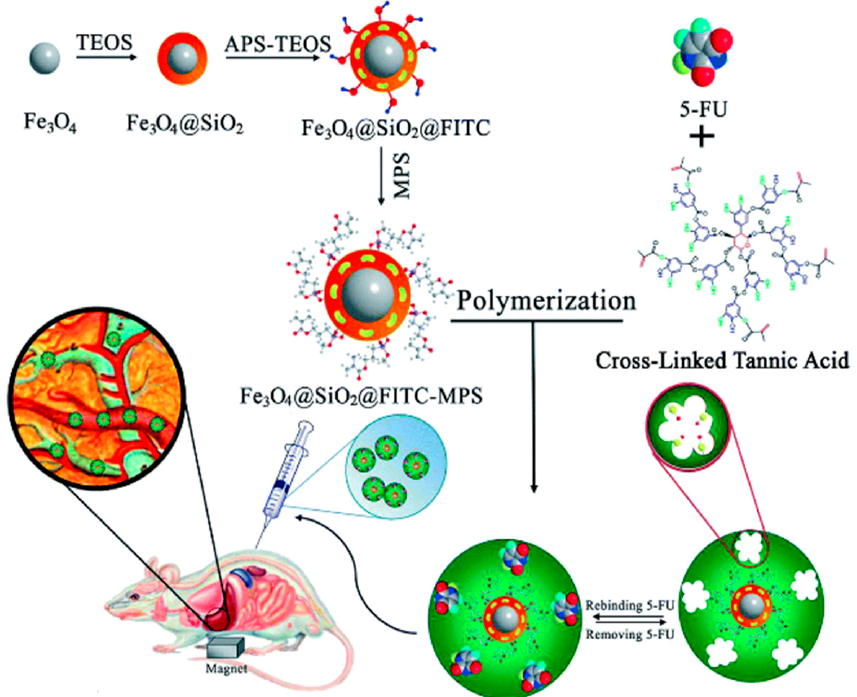
Figure 15. The procedure followed for preparation and characterization of magnetic molecularly imprinted polymer (MMIP) nanoparticles as a 5-FU carrier (TEOS: tetraethyl orthosilicate, APS: 3- aminopropyl trimethoxysilane, FITC: fluorescein isothiocyanate, 5-FU: 5-fluorouracil, MPS: methacryloxypropyl trimethoxysilane). Reproduced with permission from [116] © 2021 The Royal Society of Chemistry .